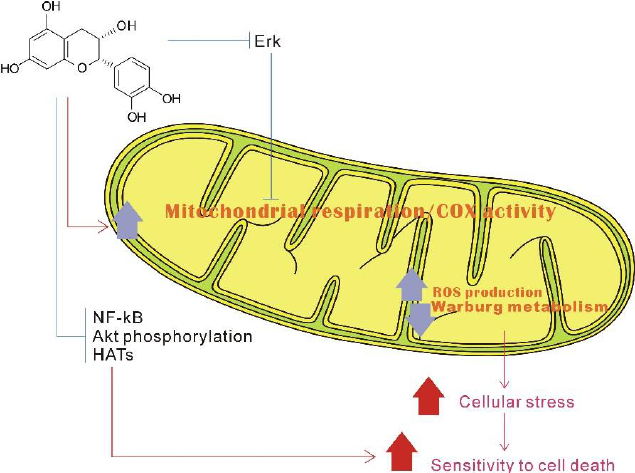
Figure 6. Possible model of catechin stimulates mitochondrial biogenesis and downregulates the